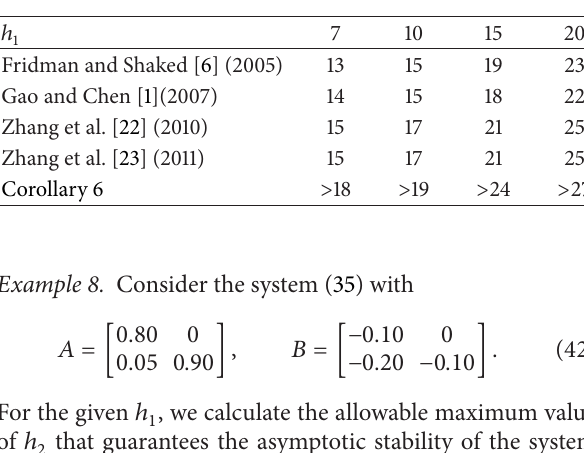
Table 2: Comparison of the maximum allowed time delay ℎ 2 for different